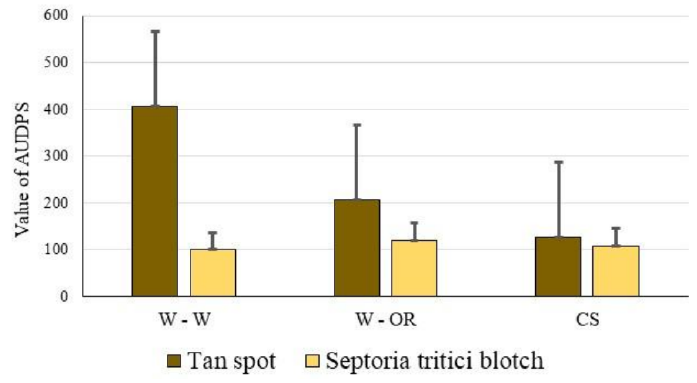
Figure 3. Development of tan spot and Septoria trit ici blotch depending on crop sequence scheme: W-W—continuous wheat; W-OR—short rotation of only wheat and oilseed rape; CS—crop sequence.